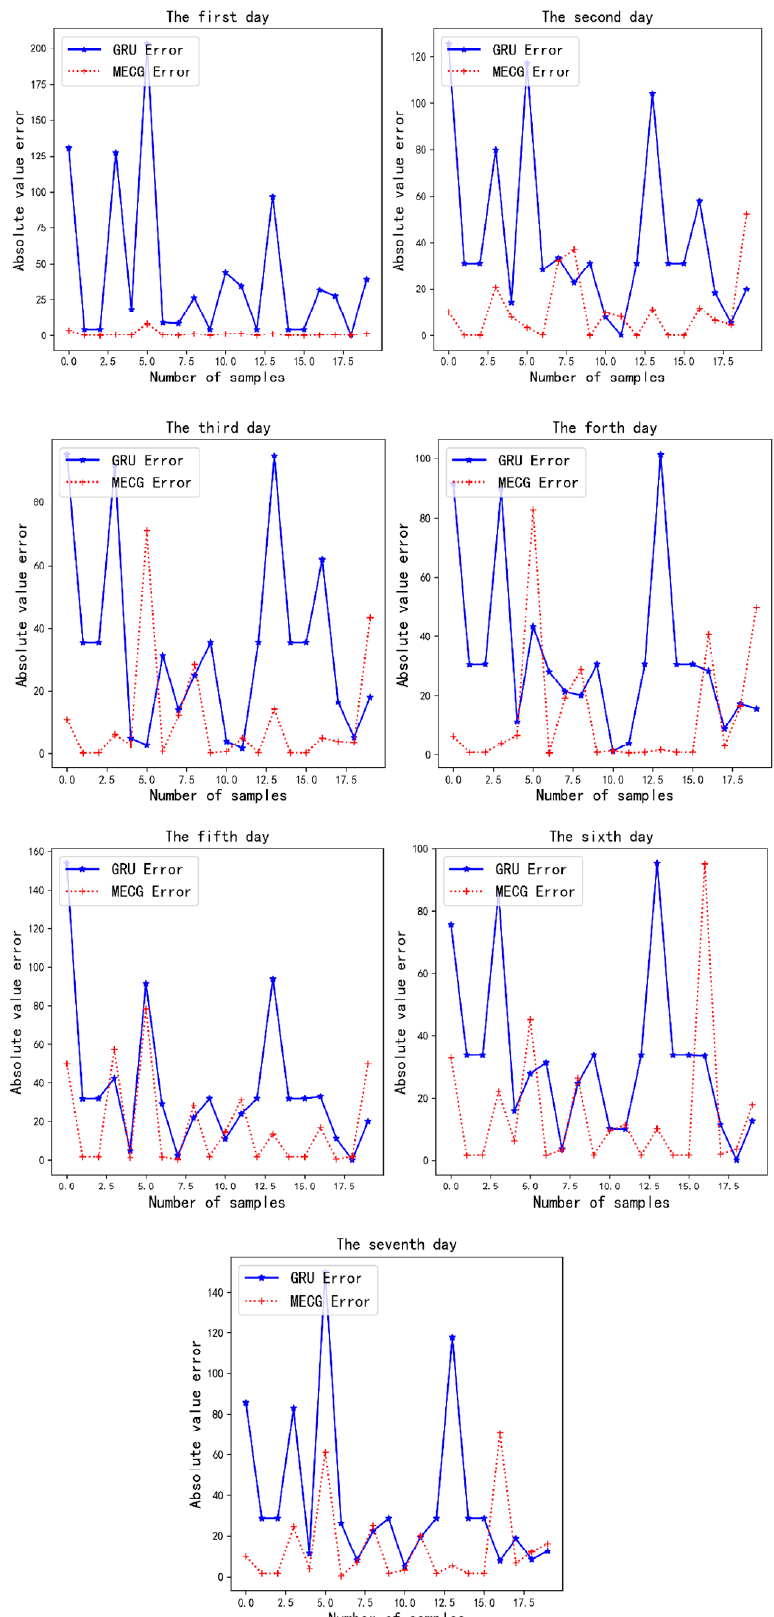
Figure 13. Absolute error values of 20 samples randomly selected by GRU and MECG.